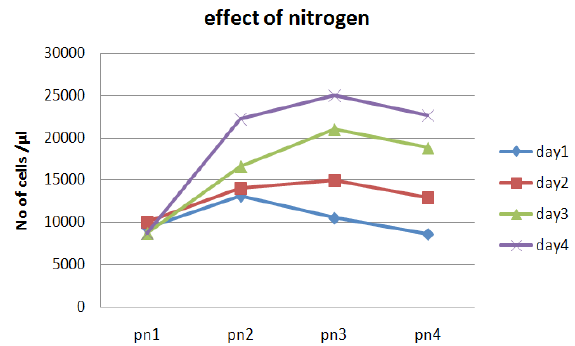
Fig. 3. Effect of low nitrogen on multiplication and growth mea- sured by cell counting